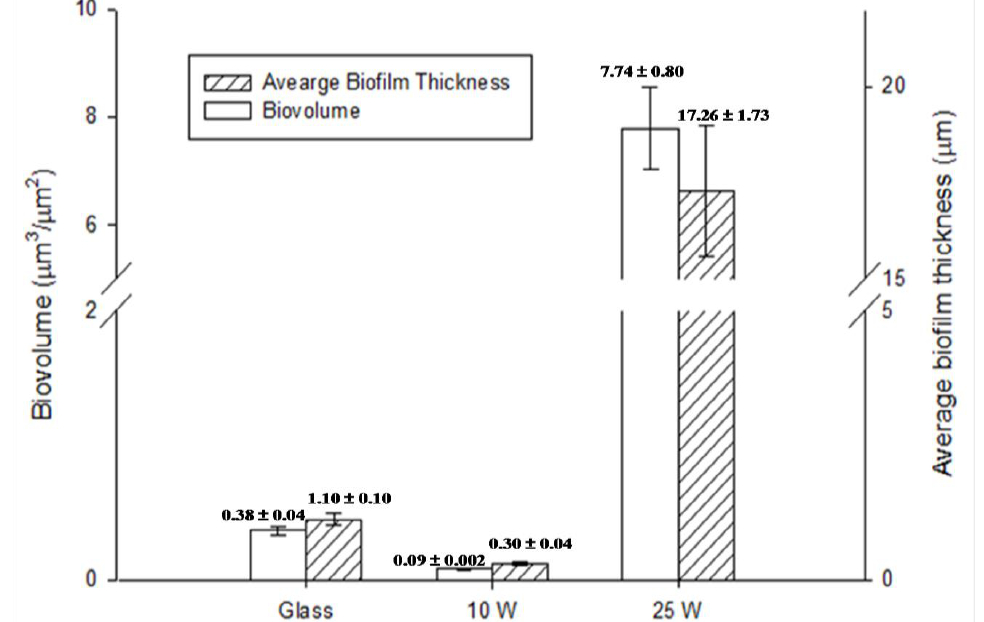
Figure 3. Quantification of S. aureus biovolume and average biofilm thickness on the surfaces of the unmodified glass and polymer coated